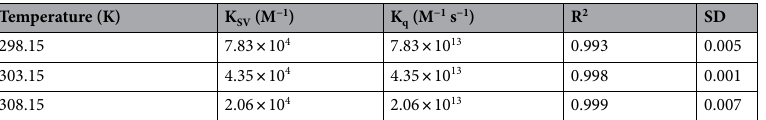
Table 1. Tabular representation of Stern–Volmer quenching constant (K SV ), bimolecular quenching constant (K q ) for the HSA-T-res system at 298.15, 303.15, and 308.15 K and pH 7.4.